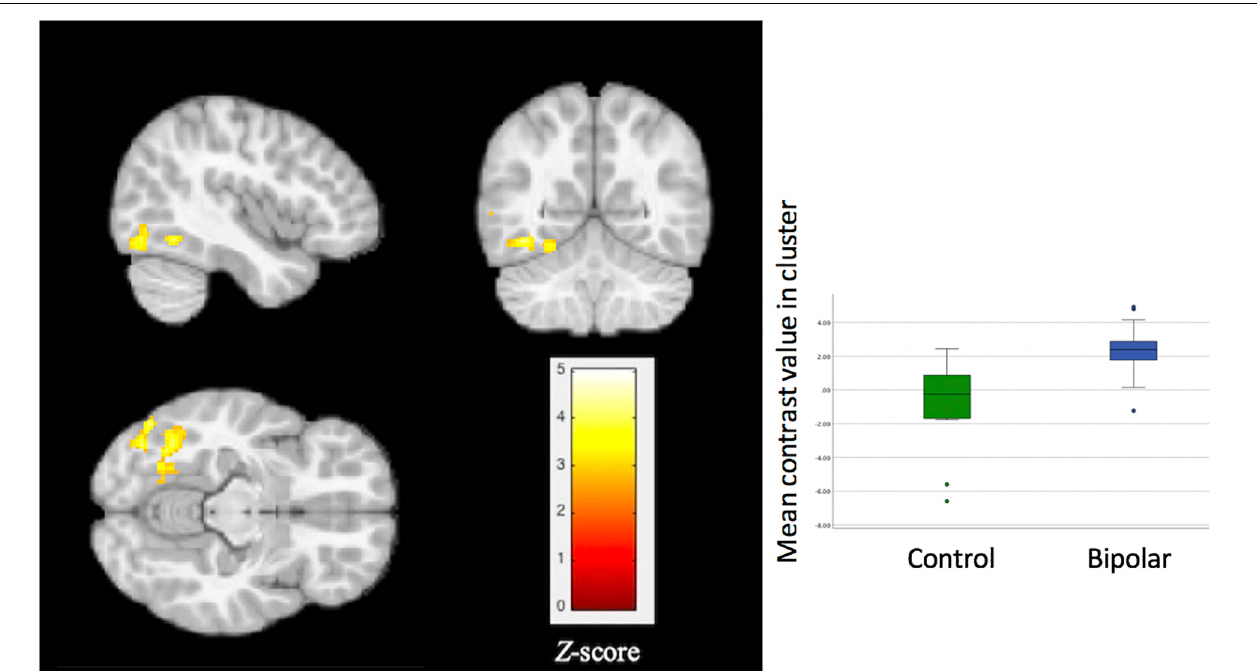
FIGURE 2 | Significant group differences in activation of the left fusiform gyrus during a social exclusion task. Compared to healthy controls, youth with bipolar disorder showed significantly greater activation ( p = 0.037) for the contrast of exclusion > inclusion. Thresholds for inference were set at p < 0.05, FWE corrected at the cluster